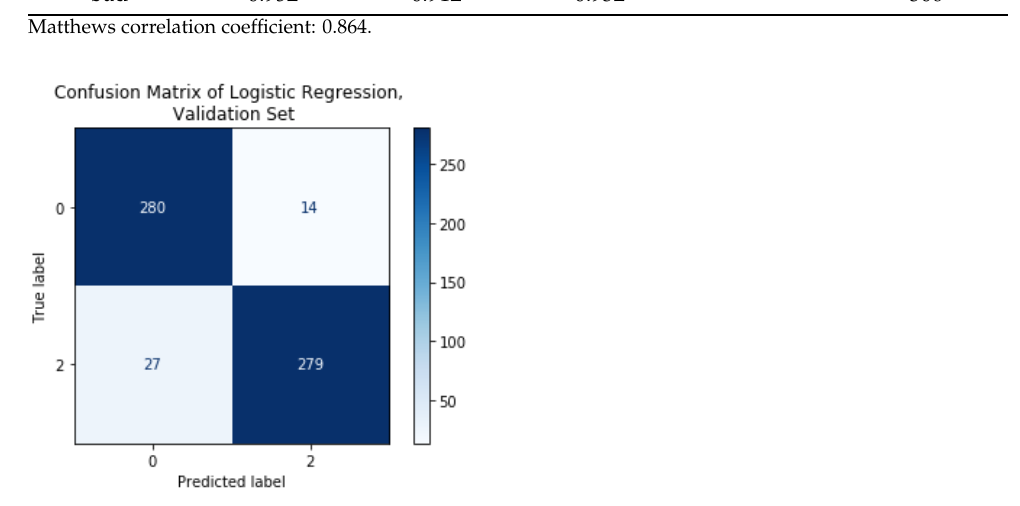
Figure 11. Confusion matrix of LoGit classification results on validation subset of 600 images.